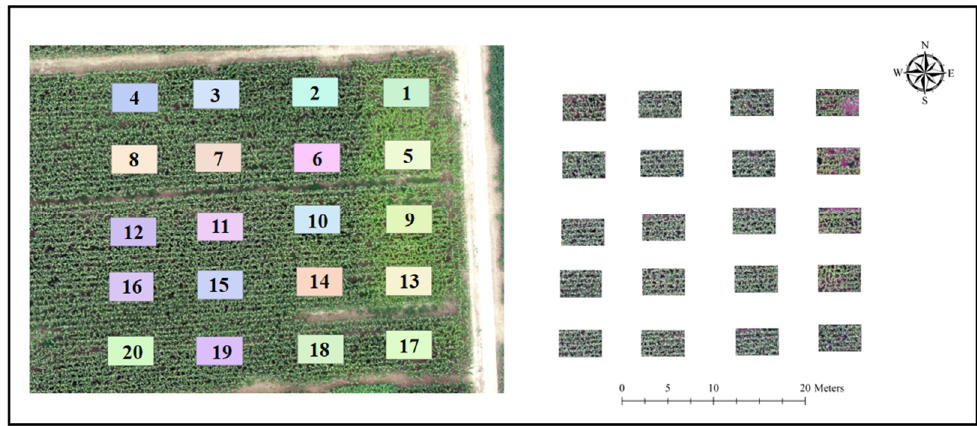
Figure 1. Brief introduction of the study area and sampling plots. Note: The left image represents the whole area and the 20 plots in different colors indicate 20 sampling plots, and the right image represents the corresponding clip subsample images of the 20 plots.